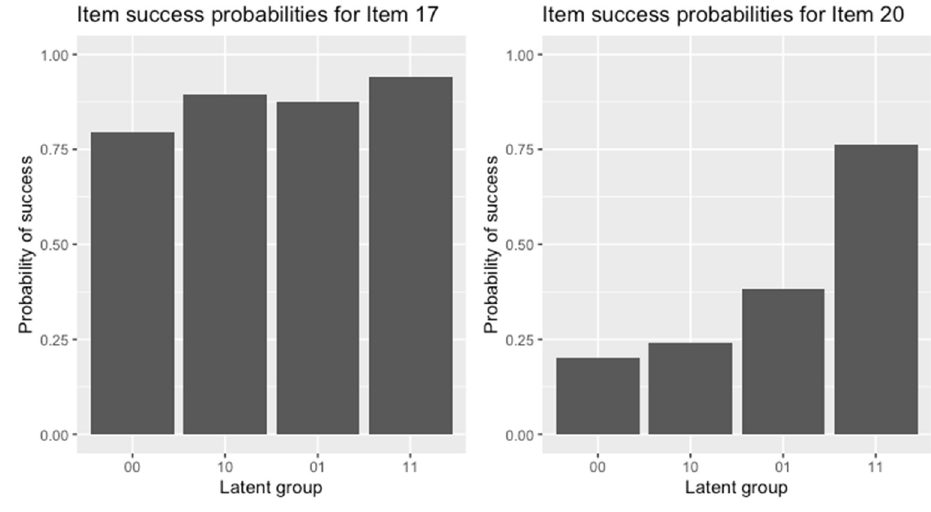
Figure 5. Plots of Success Probabilities of Items 17 and 20.